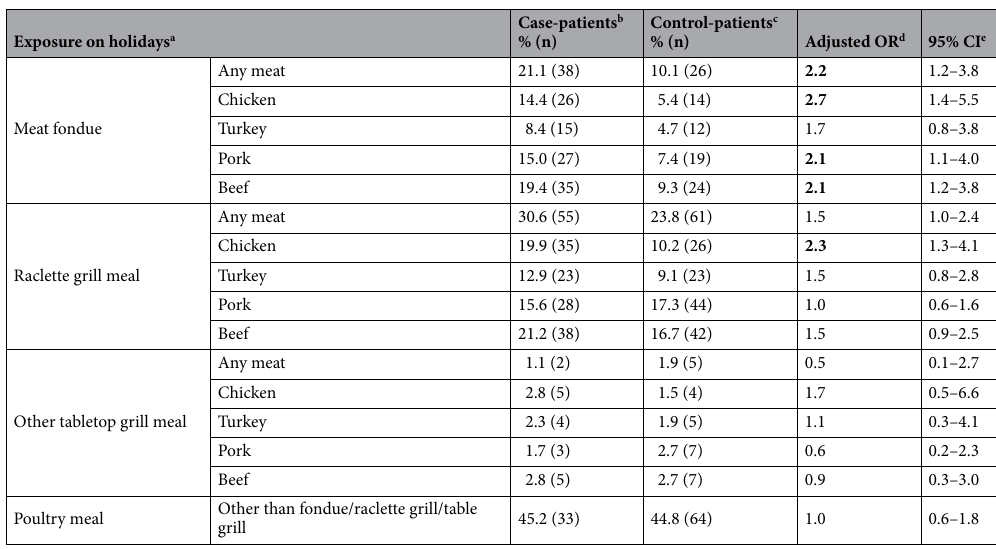
Table 2. Single variable logistic regression analysis (adjusted for sex and age group) of case-patients (n = 182) and control-patients (n = 260) regarding exposure to certain meals on the Christmas and New Year’s holidays;